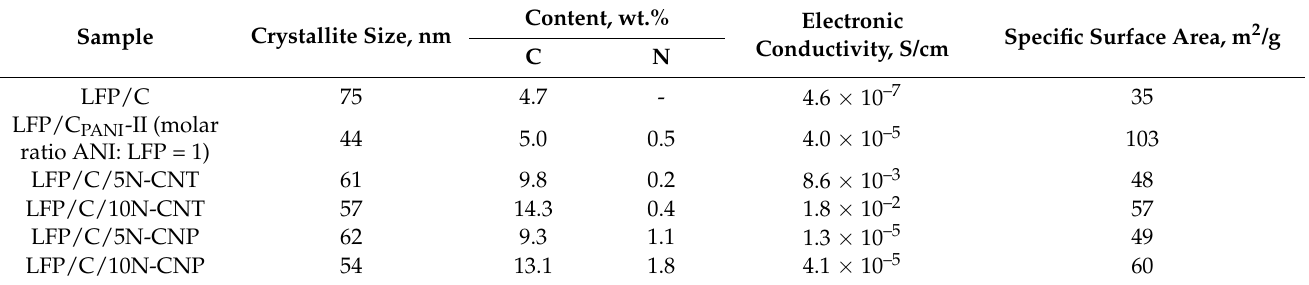
Table 1. Crystallite size, contents of carbon and nitrogen, electronic conductivity, and specific surface area of the prepared